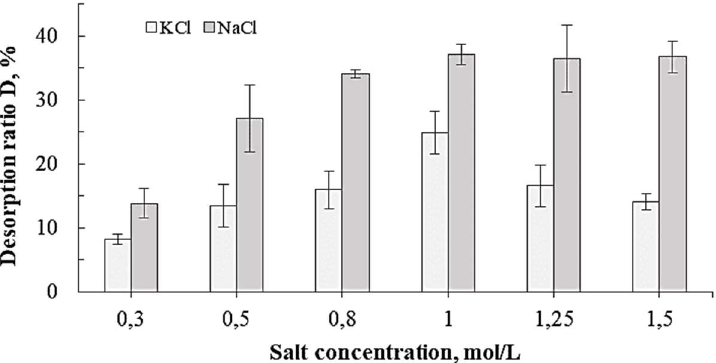
( b ) Figure 10. Application of Webber and Morris equation to the adsorption data of ( a ) sinigrin and ( b ) gluconapin using PA312LOH resin (resin concentration 20 g/L, 30 °C). The experimental points are represented by the symbols “ ■ ” and “ ▲ ” 3.1.4. Glucosinolates Desorption Optimization Influence of the Salt Concentration KCl and NaCl were selected to perform the desorption in static mode based on their ability to solubilize glucosinolates. Indeed, glucosinolates can be easily dissolved in KCl or NaCl solutions to form ionic salts with K + or Na + . The influence of salt concentration on the desorption of sinigrin in KCl and NaCl at 30 °C and 300 rpm for 90 min is presented